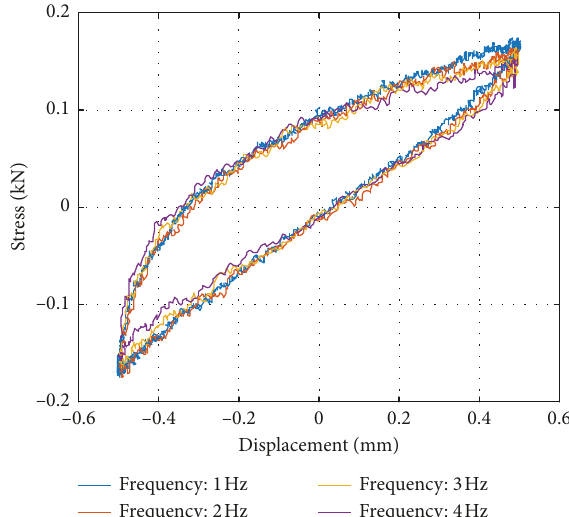
MR (cid:31) 2.5 g · cm